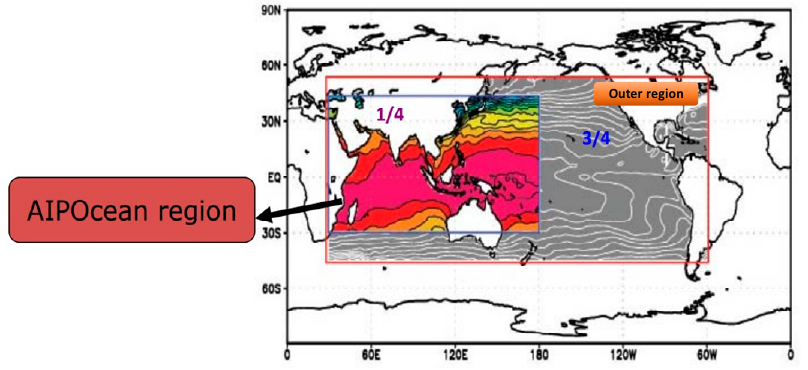
Figure 1. The geographical location of the AIPOcean region and the peripheral area used in the establishment of the grid model.